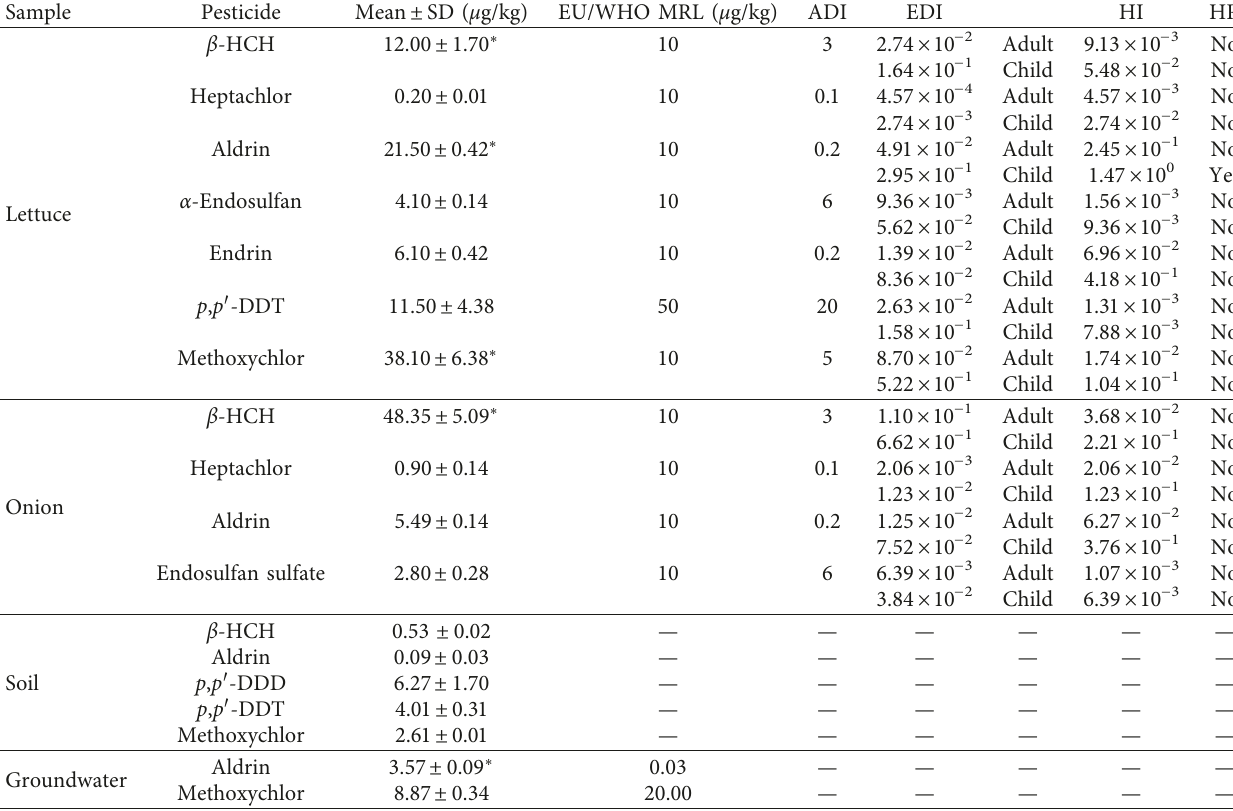
Table 4: Concentration, EDI, and health risk estimation for OCP residues detected in vegetables from Nsenie. Sample Pesticide